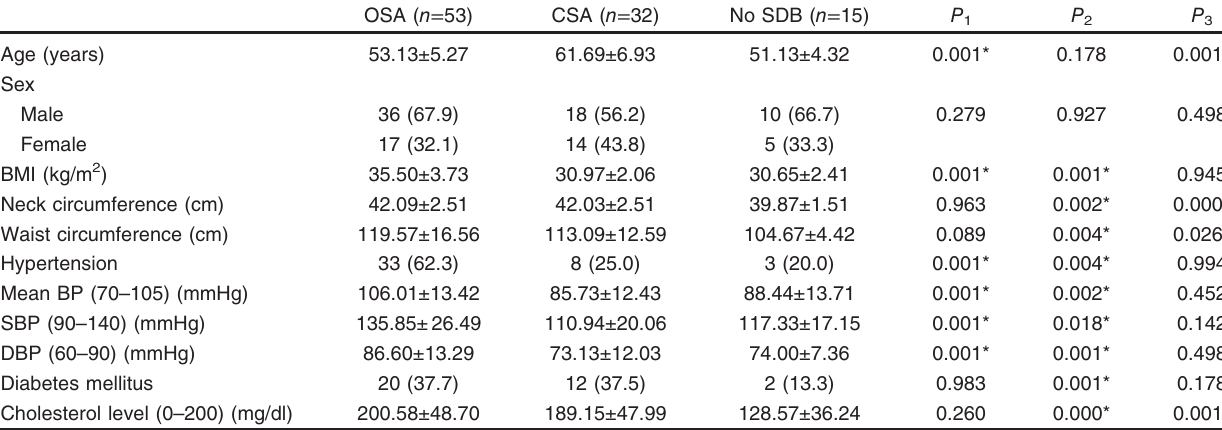
Table 2 Anthropometric measures, demographic data, and comorbidities among obstructive sleep apnea, central sleep apnea and no sleep-disordered breathing in heart failure